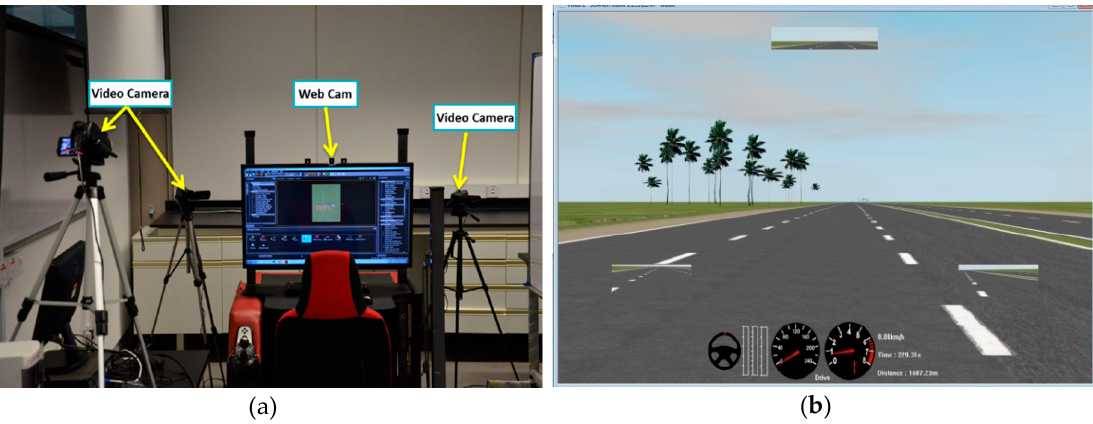
Figure 1. ( a ) Experimental setup to induce drowsiness; ( b ) view of a monotonous driving